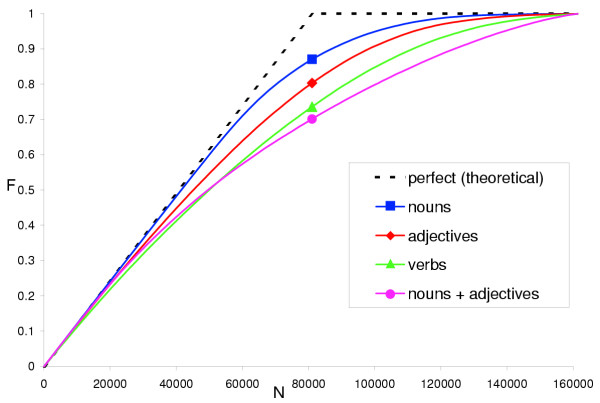
Self-consistency test of the algorithm. Fraction of references from the stem cell training set (F) retrieved when selecting a number (N) of top-scoring references in a mixed set combining the training set and the random set. Nouns are better discriminators with F = 0.87 for the top half of the list. F was 0.79 for adjectives, 0.73 for verbs, and 0.70 for nouns plus adjectives. Performance could not be theoretically perfect because there were articles in the training set which were not relevant to stem cells, and there were articles in the random set which were relevant to stem cells.